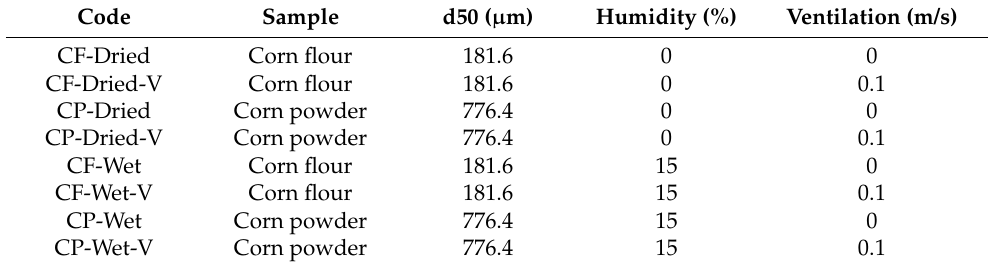
Table 2. Experiments performed .